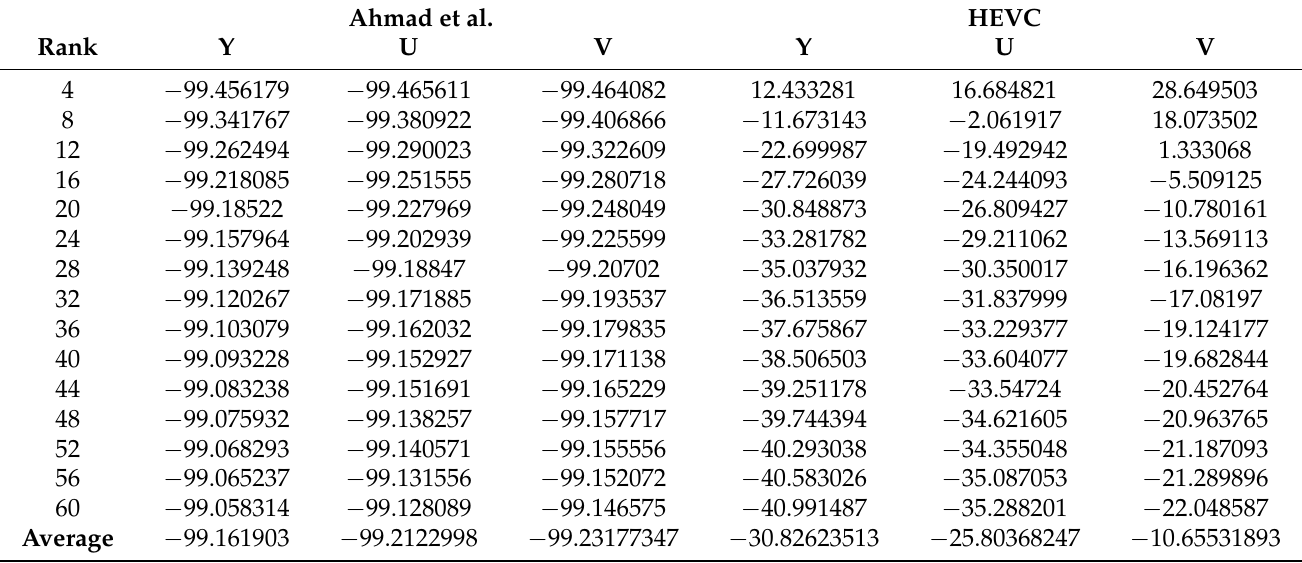
Table 5. Bjontegaard percentage rate savings for the proposed compression scheme with respect to Ahmad et al. and HEVC codec (negative values represent gains) on Stone-Pillars Outside data.